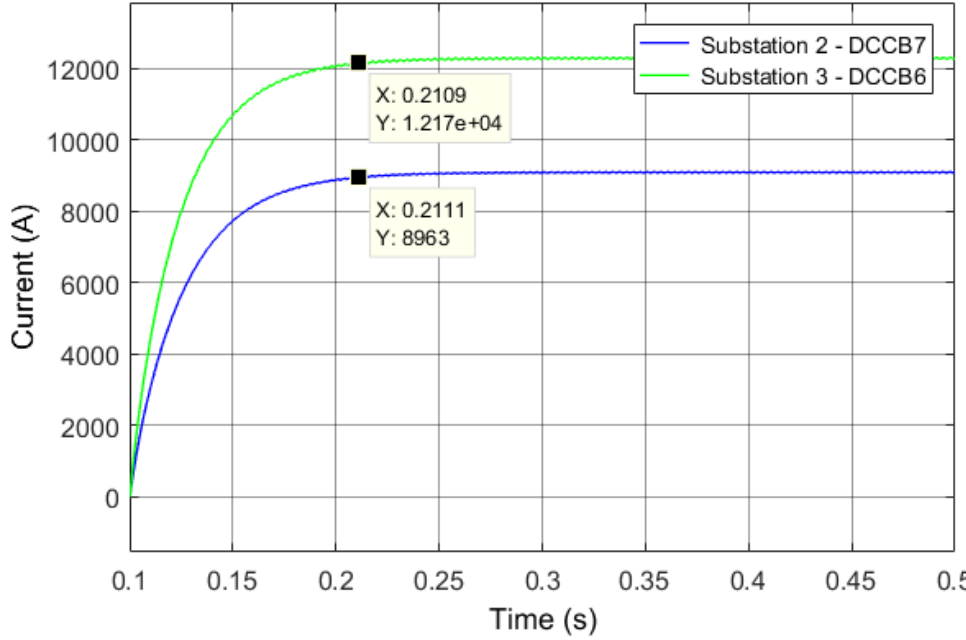
Figure 17. Simulation results of Scenario F4. Fault current (A) vs. time (s) observed with DCCB7 (Substation 2—blue) and DCCB6 (Substation 3—green).